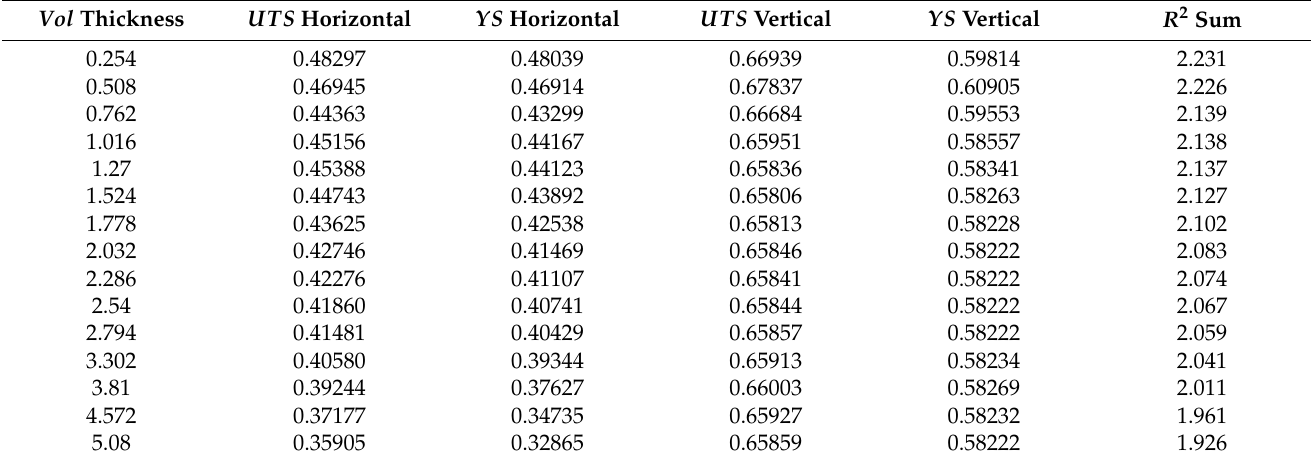
Table 3. R 2 values for predicted UTS and YS for the horizontal and vertical components utilizing a range of values for the volume in the z , or vertical, direction in order to optimize the accuracy of the predicted results for all components of the stresses.